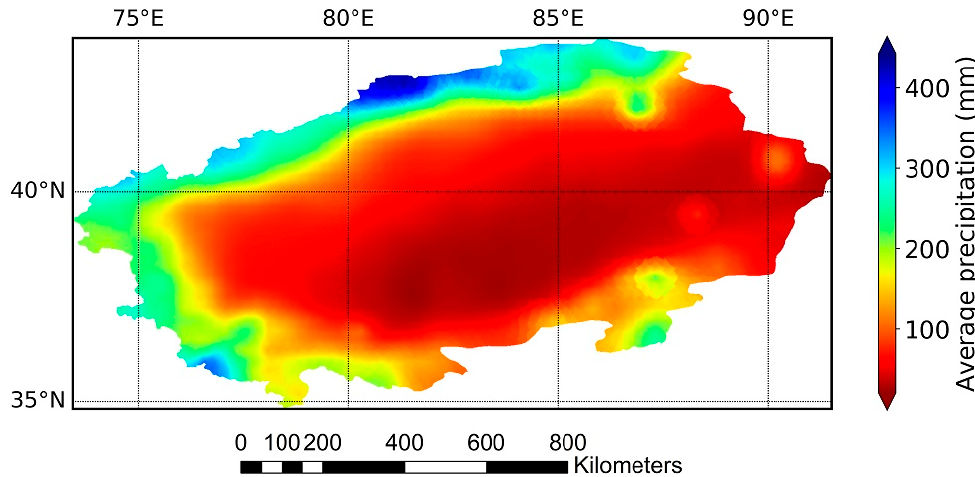
Figure 9. The spatial distribution of the annual average precipitation.